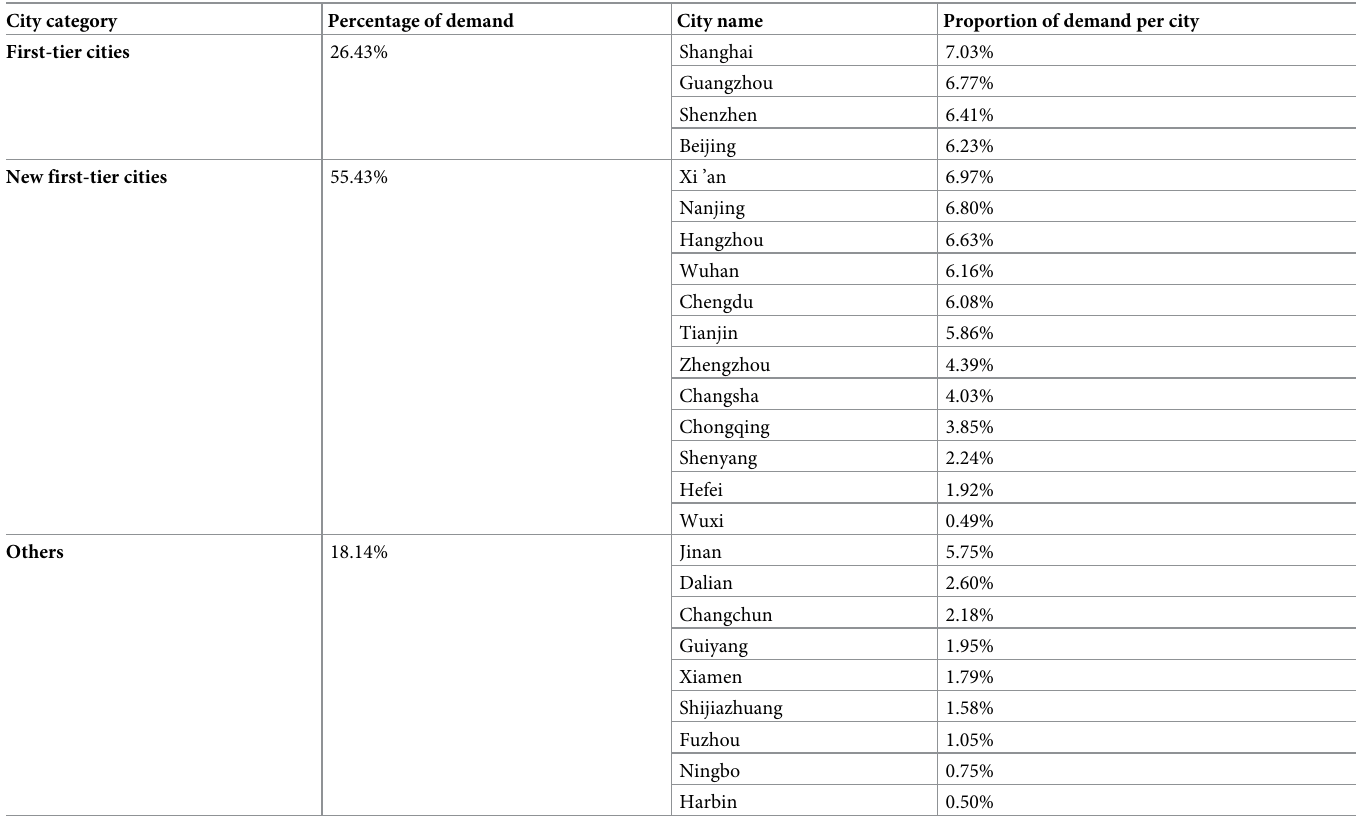
Table 4. The proportion of job demand in each